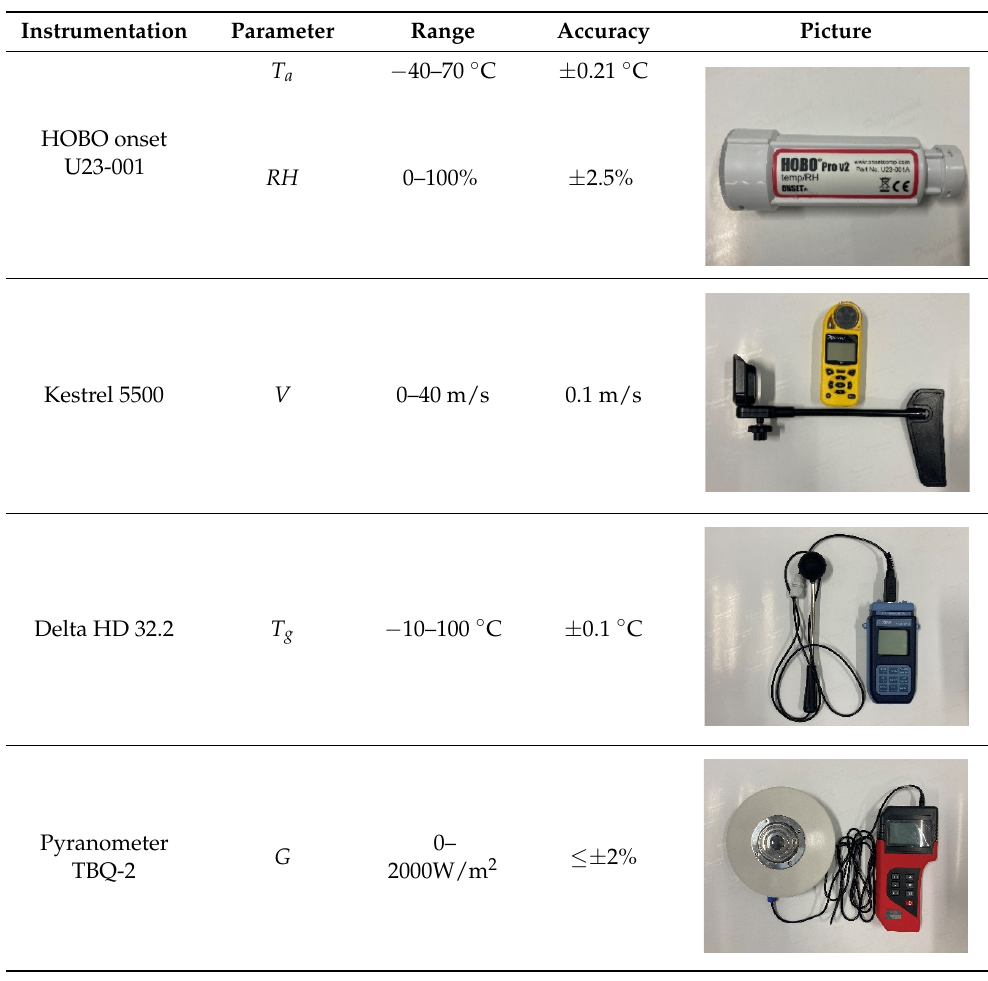
Table 1. Technical details of meteorological equipment.